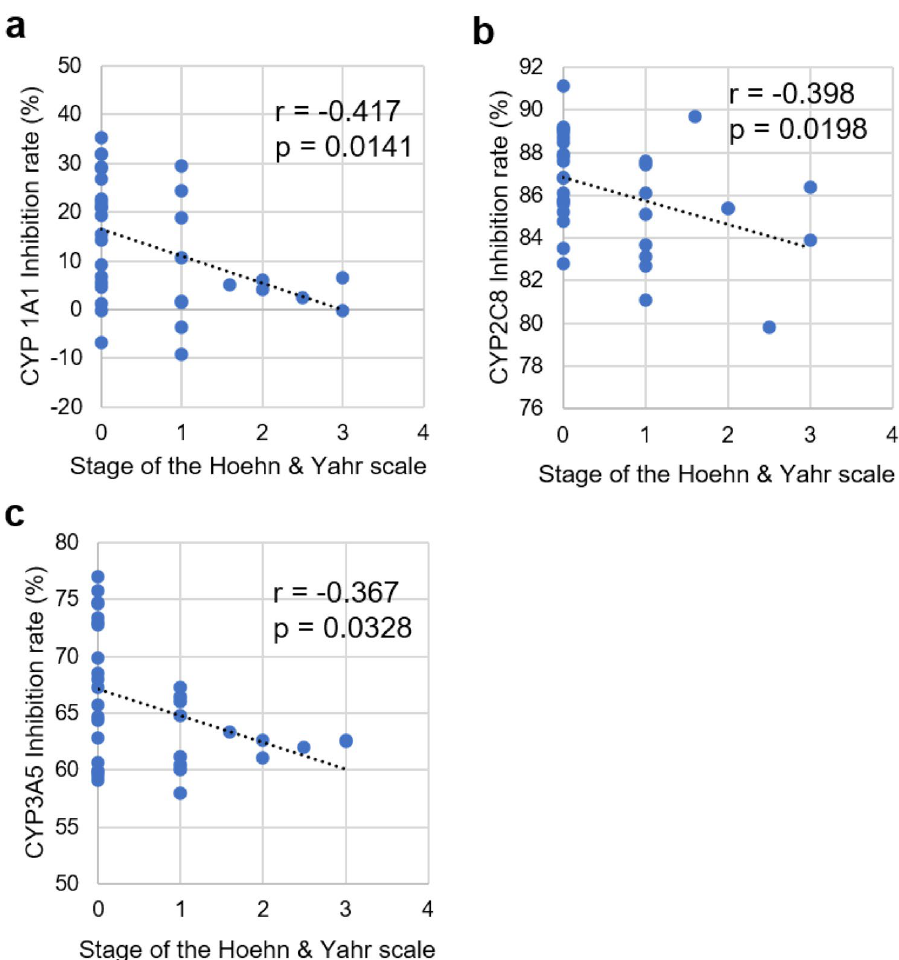
Figure 8. Correlation of inhibition rate of reactions involving CYP1A1, CYP2C8, and CYP3A5 and the stage of the Hoehn and Yahr scale. ( a ) Scatter plot of the inhibition rate of the reaction for CYP1A1 and the stage of the Hoehn and Yahr scale. ( b ) Scatter plot of the inhibition rate of the reaction for CYP2C8 and the stage of the Hoehn and Yahr scale. ( c ) Scatter plot of the inhibition rate of the reaction for CYP3A5 and the stage of the Hoehn and Yahr scale. Spearman’s rank correlation coefficient (r) and the result of the test showing no correlation (p) are presented in each